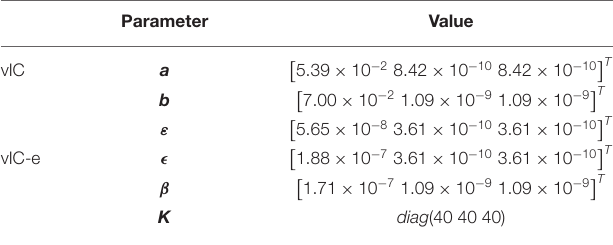
TABLE 1 | Parameters of the